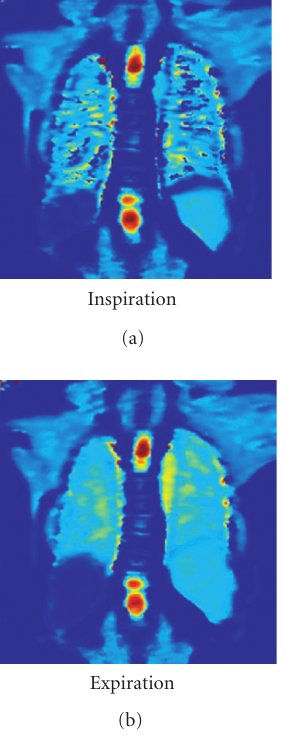
Figure 6: T1 map of a Patient with lung fibroses: in comparison to a healthy lung (Figure 2), the T1 time is shortened. Expiration (b) shows a significant T1 time prolongation as compared to inspiration (a).